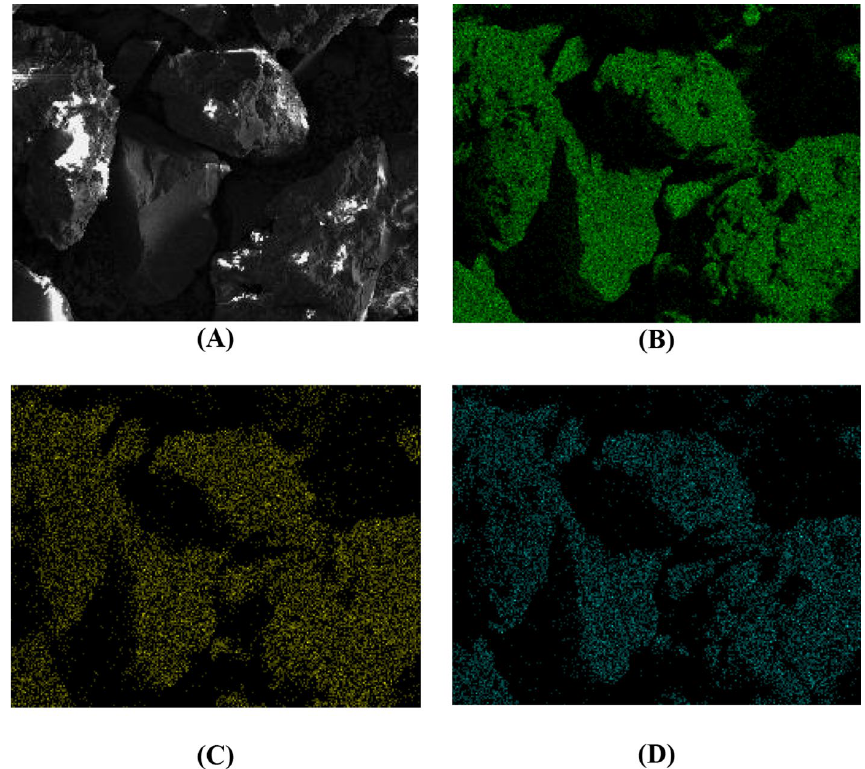
Figure 5. Scanning Electron Microscopy (SEM) micrograph (A) and respective Electron Dispersive Spectroscopy images (EDS) of Si (B) , Ti (C) and Nb (D) for SiTiNb-A material. Magnification of